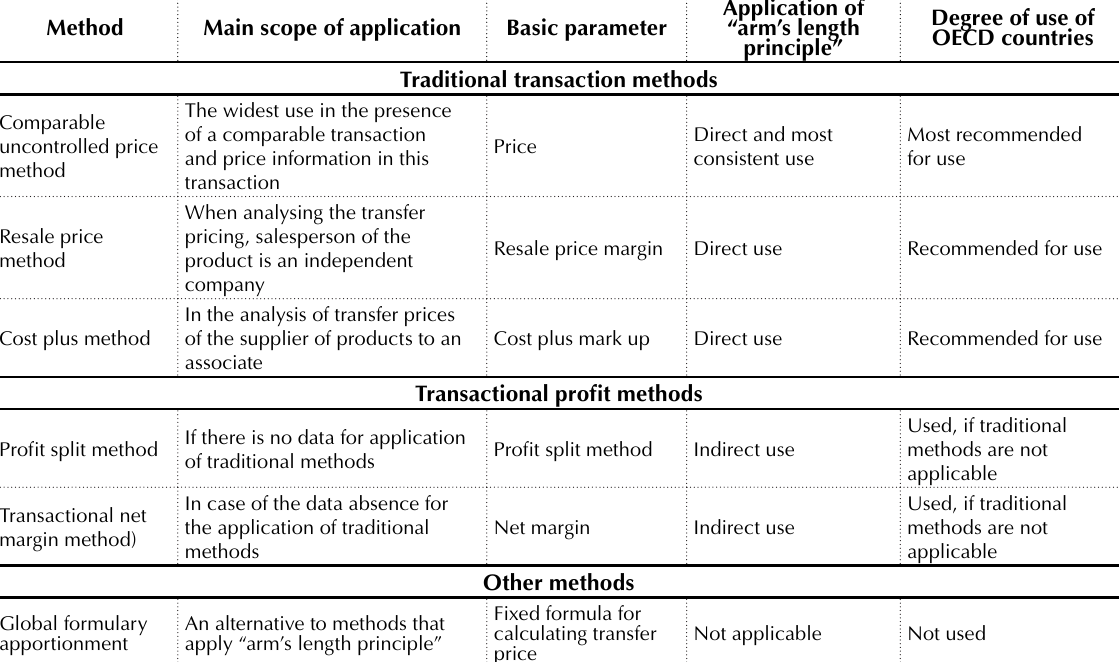
Source: made by the authors on the basis of OECD